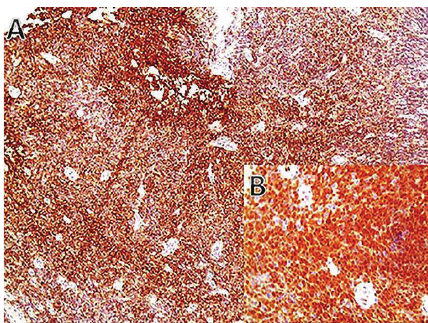
Figure 3: Immunohistochemical staining showing a diffuse CD20 positive B-cells ((A), 40x) coexpressing cyclin-D1 (B)